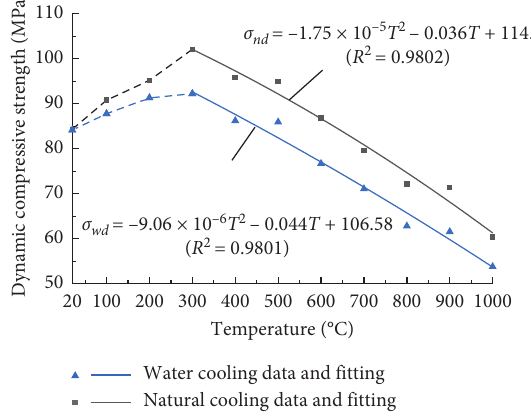
Figure 8: Dynamic compressive strength of high temperature sandstone after two cooling